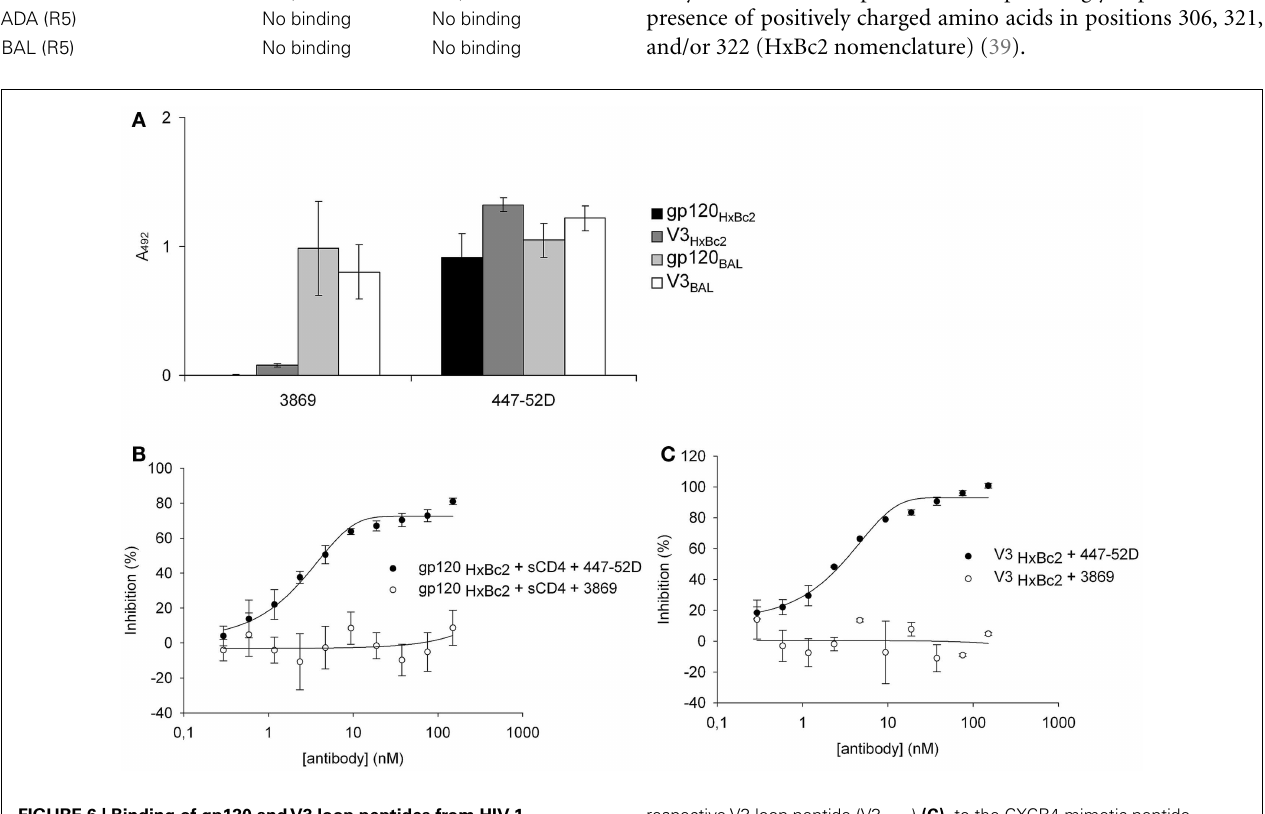
FIGURE 6 | Binding of gp120 andV3 loop peptides from HIV-1 strains HxBc2 ( + QR) and BAL ( − QR), to mAbs 3869 and 447-52D (A) . Dose-dependent effect of mAbs 447-52D and 3869, respectively, on binding of gp120 HxBc2 (in the presence of sCD4) (B) and the